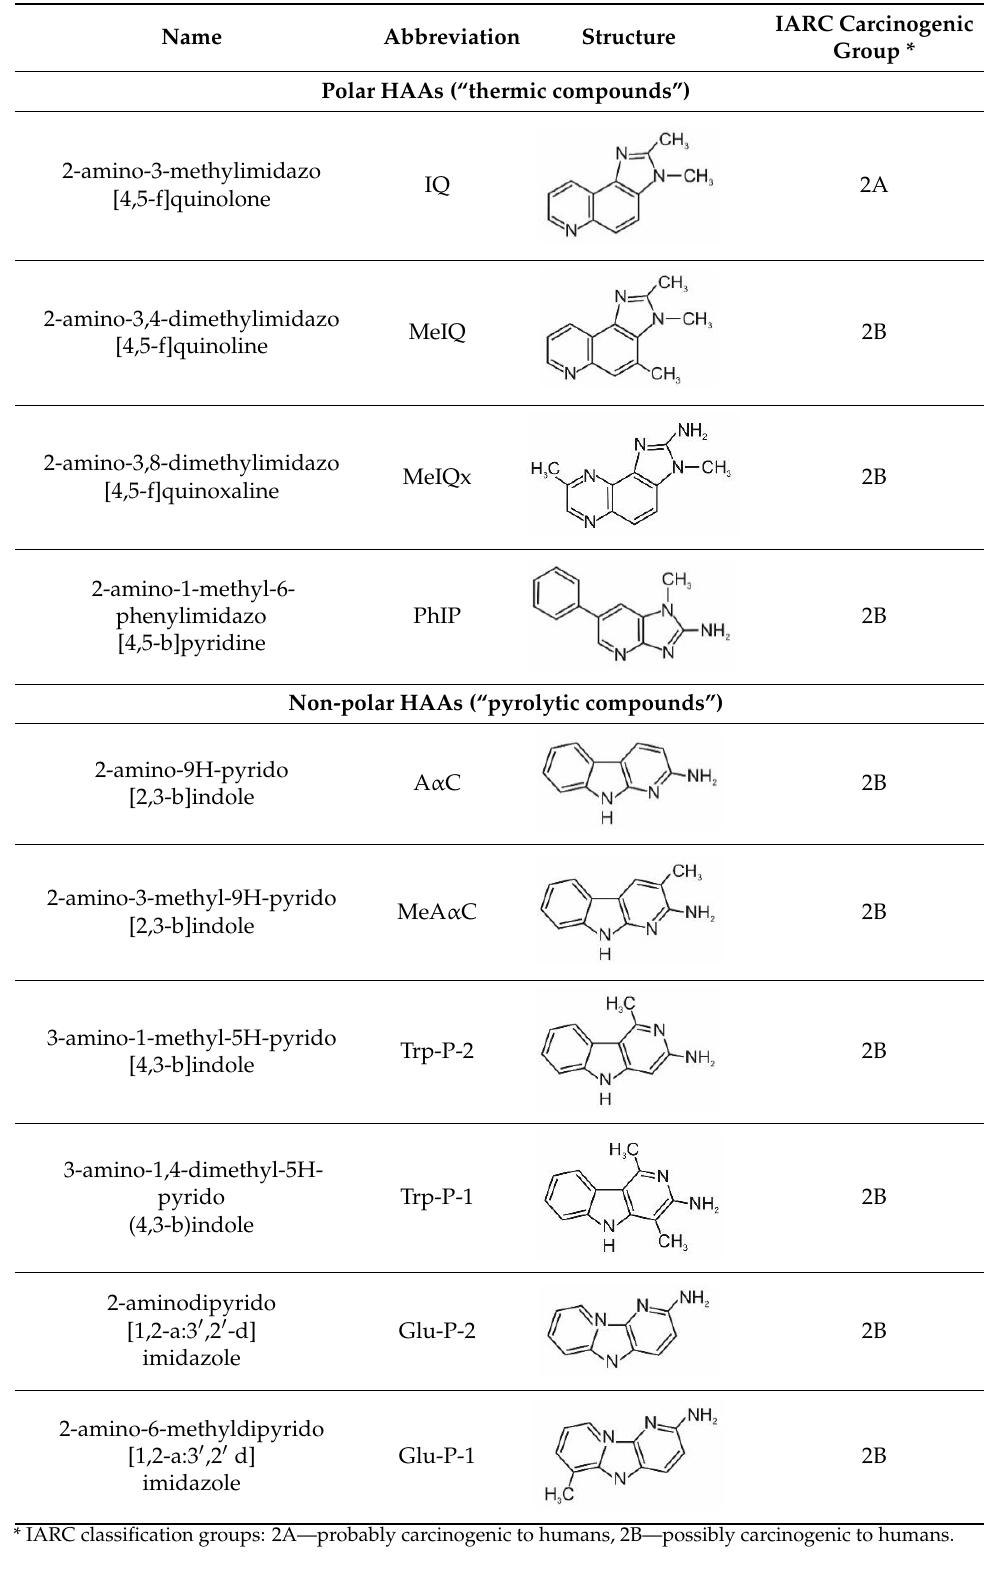
Table 2. Heterocyclic aromatic amines classified by IARC as carcinogenic [42].